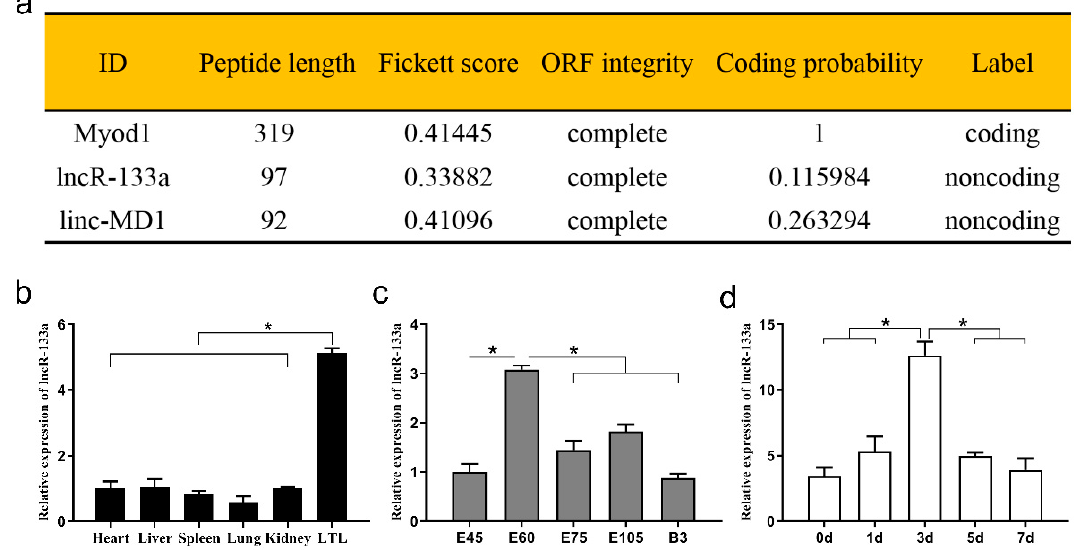
Figure 1. Coding potential and expression profile of lncR-133a. ( a ) Bioinformatics analysis of the coding potential of lncR-133a, and Myod1 and linc-MD1 served as controls. ( b ) qRT-PCR analysis of lncR-133a expression in heart, liver, spleen, lung, kidney, and longissimus thoracis et lumborum (LTL) muscle on day 60 of gestation. ( c ) The expression pattern of lncR-133a in the developmental LTL muscle. ( d ) The expression levels of lncR-133a during goat MuSC differentiation. Data are means ± standard error of the mean of at least three biological replicates, * p < 0.05.